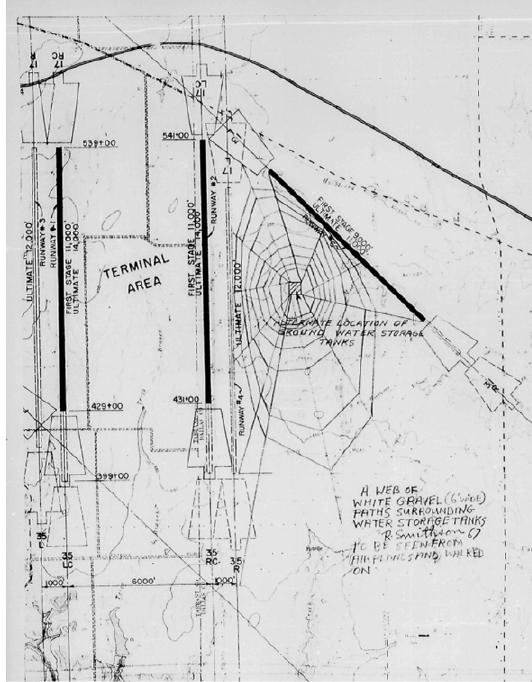
Figure 13. Robert Smithson, A web of White Gravel (1967). RSP, Projects, Reel 3834 Frame 299. Landscape design for the spaces between DFW runways, “to be seen from the air”